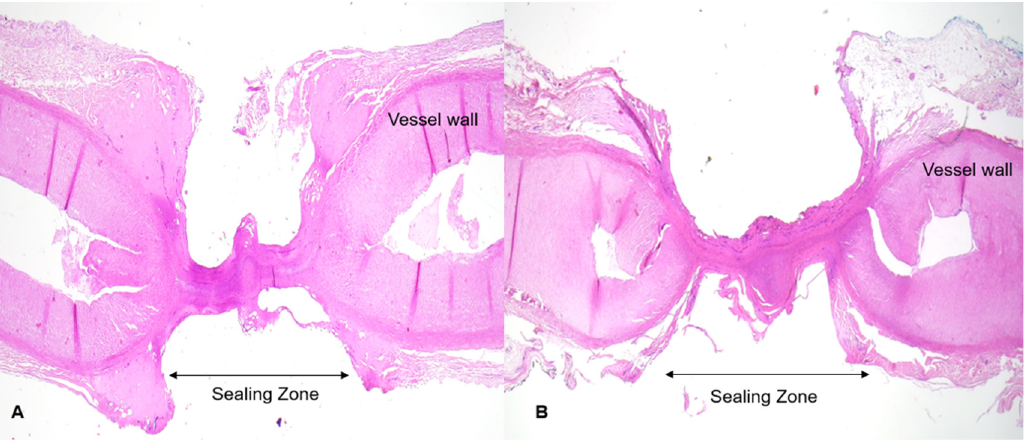
Figure 3. ( A ) Vessel just sealed by marSeal 5 plus ( B ) Vessel sealed by BiCision (HE staining) (magnification 4.5×).